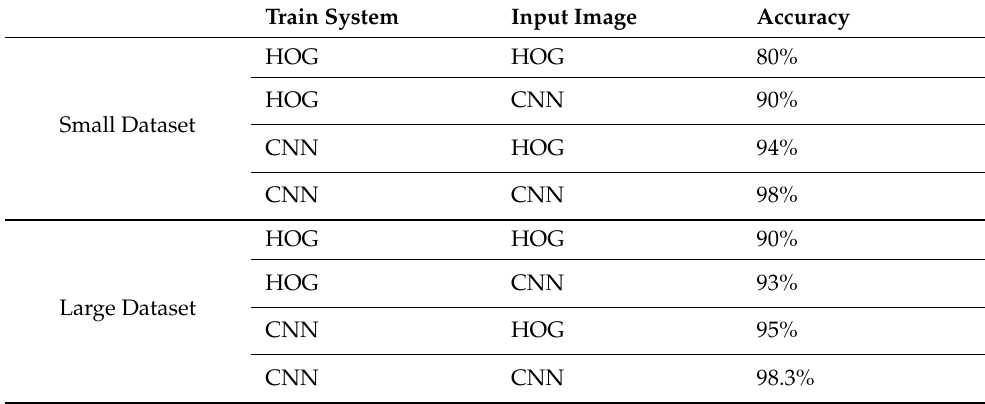
Table 3. Performance of algorithms under different training conditions.